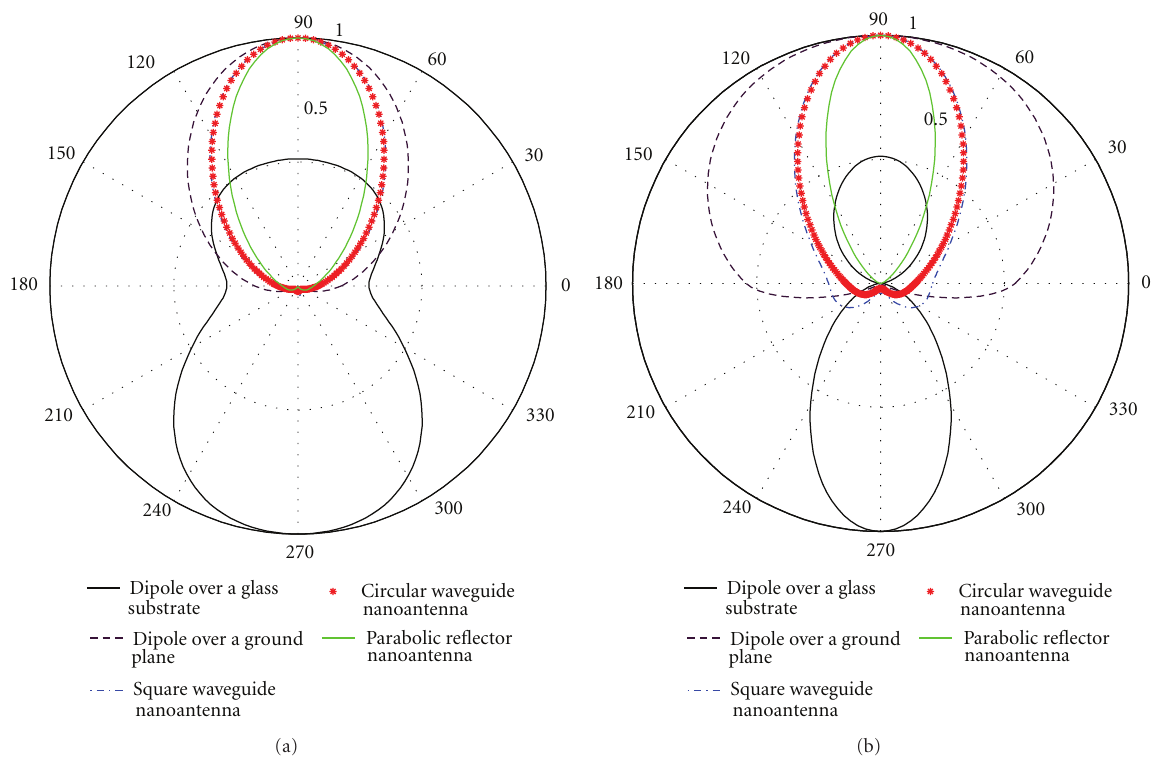
Figure 4: Radiation patterns of a dipole antenna on a glass substrate, dipole over ground plane, square waveguide nanoantenna (side length = 500nm), circular waveguide nanoantenna (radius = 250 nm), and parabolic reflector nanoantenna. Calculated using far-field projections of 3D FDTD simulations, (a) xz plane, (b) yz